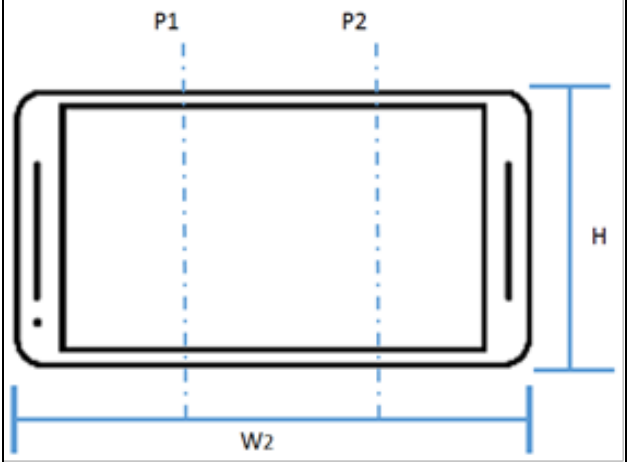
Figura 6: Determinación de la posición relativa del objeto. Fuente: Los autores, (2018).